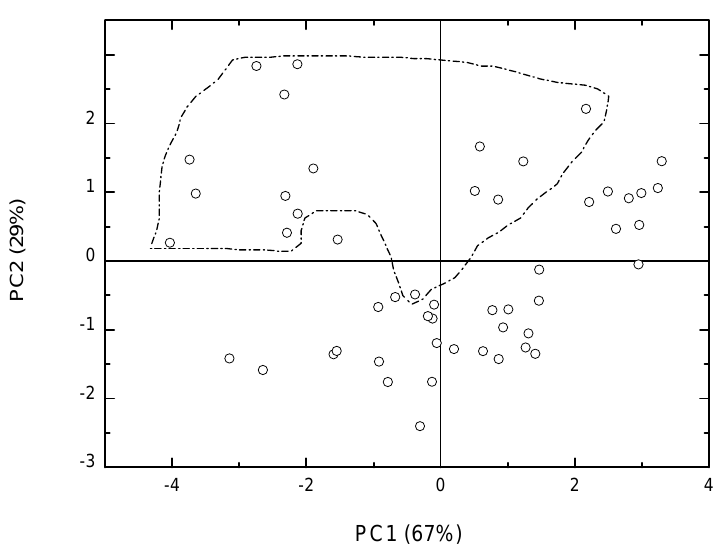
Figure 1. PCA score plot of all samples in test mixtures of key odorants containing ammonium at pH 6. Samples surrounded by dashed line (16 samples) contain high ammonium concentration (10 -4 to 10 -3 M). Full cross validation was used and six electrodes were